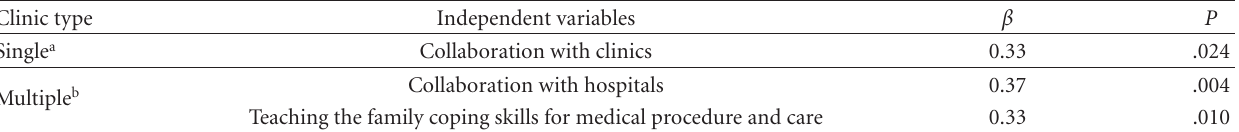
Table 5: Factors influencing the proportion of home